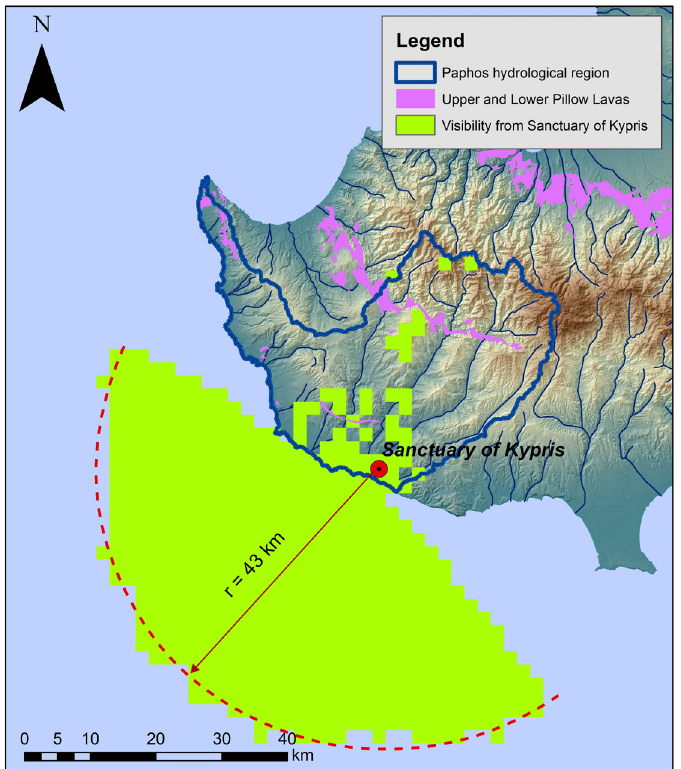
Figure 15. View-shed analysis from the sanctuary towards the seascape. Drafted by A. Agapiou